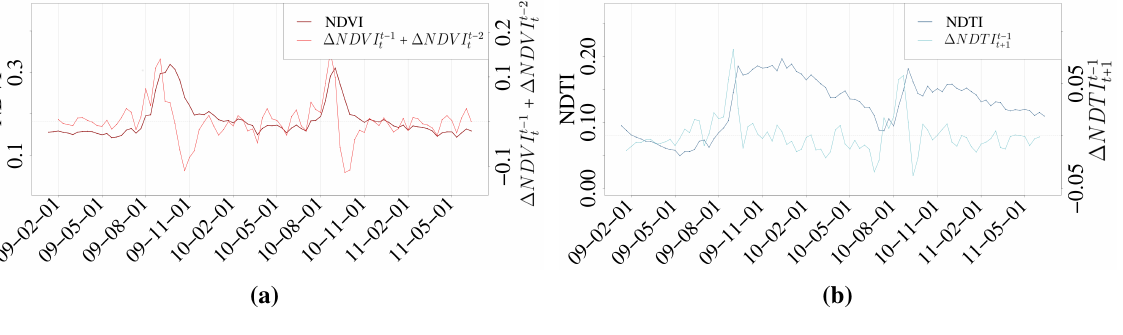
Figure 4. Temporal profiles (2009–2011) of NDV I , ∆ NDV I t − 1 and ∆ NDT I t − 1 of a RAMSES t + 1